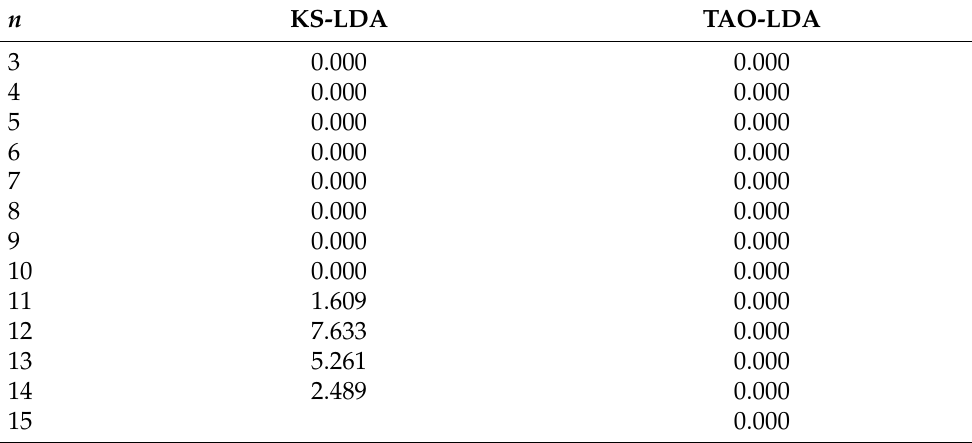
Table 2. Difference E UR (in kcal/mol) between the lowest spin-restricted singlet energy and lowest spin-unrestricted singlet energy of n -HGQR, calculated by KS-LDA and TAO-LDA. n KS-LDA